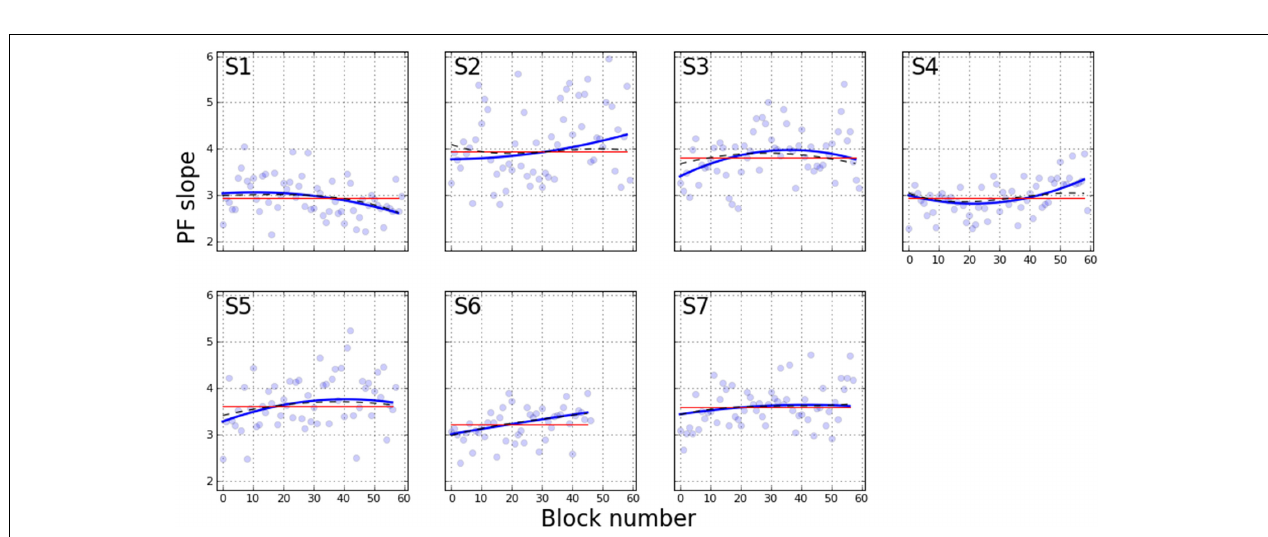
nearly indistinguishable. Dashed black lines show exponential fit. Pale blue dots represent PFs fit independently to each individual block.